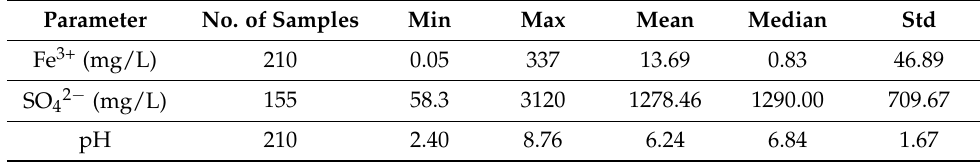
Table 1. Statistics of the water quality